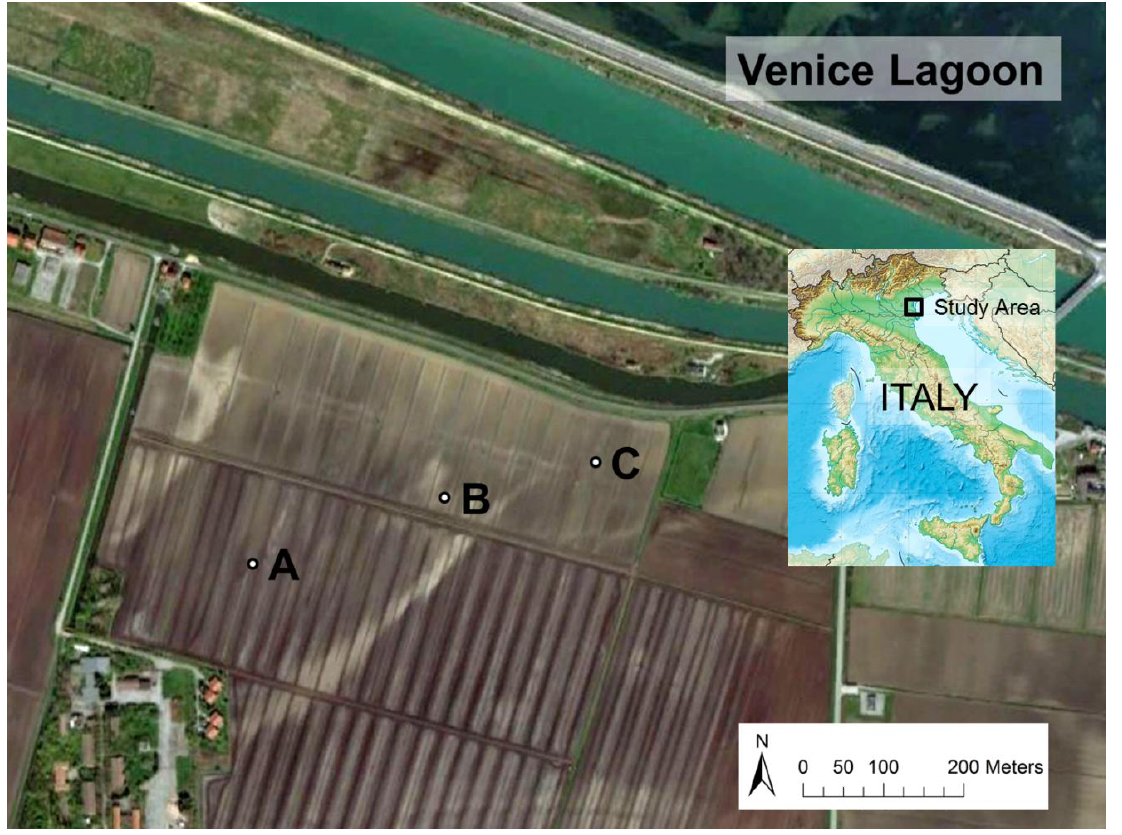
Figure 1. Aerial image of the study area at the southern edge of the Venice Lagoon, Italy. The sampling sites A, B, and C are marked.